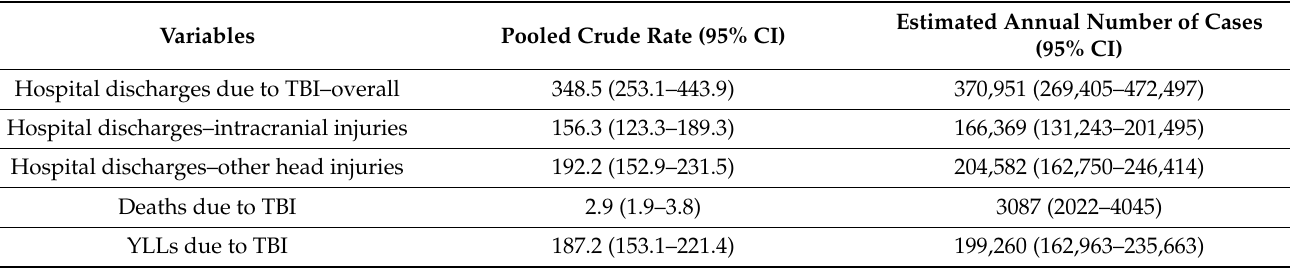
Table 2. Estimated numbers of hospital discharges, deaths and YLLs due to TBI extrapolated to the population of 0–19 year-olds in the European Union (both sexes combined).